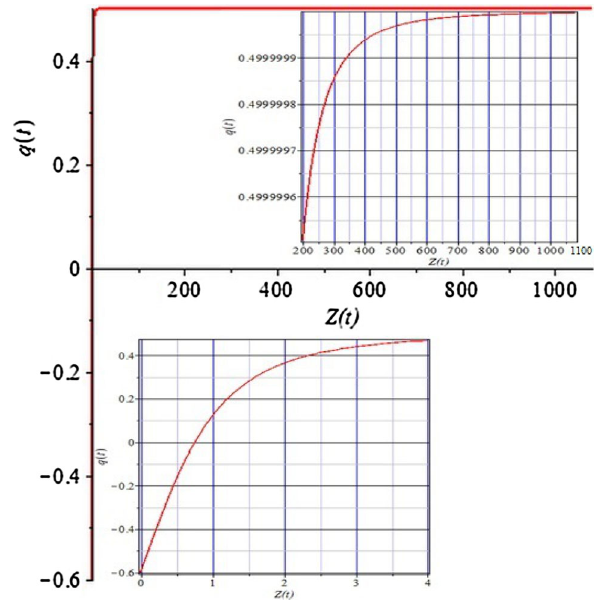
Fig. 5 Deceleration parameter q versus redshift z plot indicates a long matter dominated era till z ≈ 4. Accelerated expansion starts at z = 0 . 75. The present value of the deceleration parameter q 0 = − 0 .